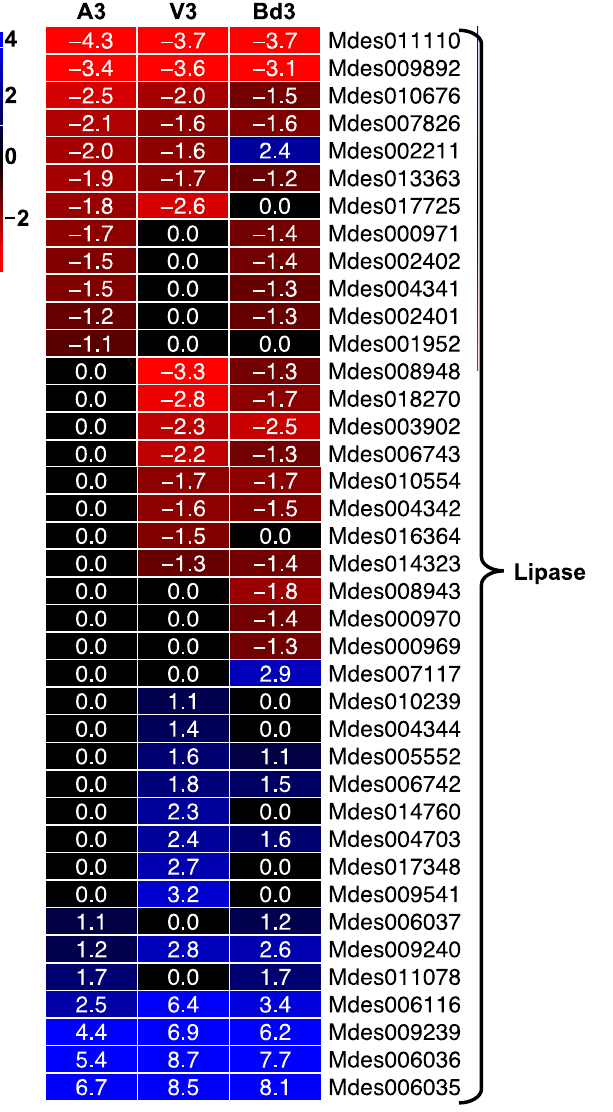
Figure 11. Differential expression of lipases in Hessian fly larvae 3 days after hatch (DAH). Heatmap depicts differential expression of genes encoding lipases in avirulent (A3), virulent (V3), and Bd3 larval transcriptomes. Log2 fold-change RNA-Seq values are shown within each cell of the heatmap. Blue represents up-regulated genes, and red represents the down-regulated genes, while genes not differentially expressed at a particular time-point are indicated in black.